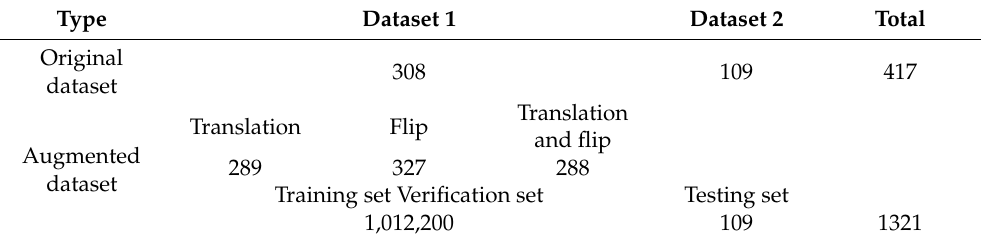
Table 1. Description of original and augmented datasets.